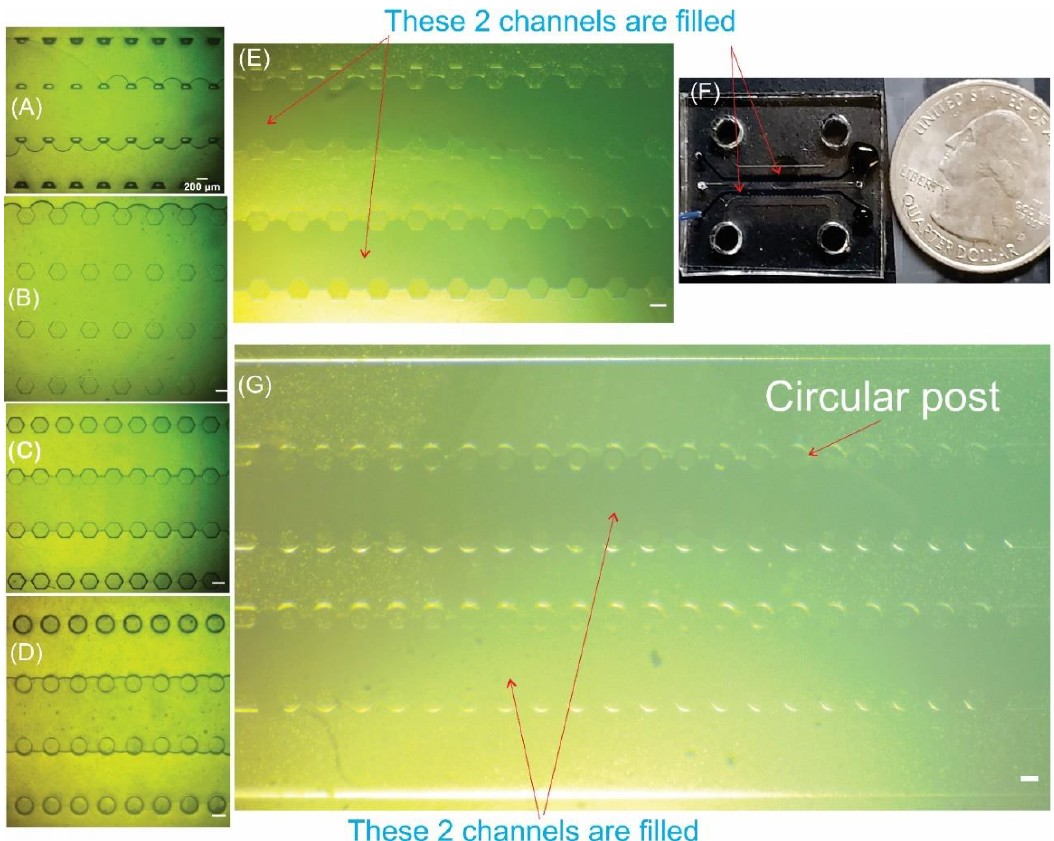
Figure 5. Microscope images of leakage from the middle channel to the neighboring compartments during liquid infusion using chips with 200 µm spacing distance for ( A ) trapezoidal posts and ( B ) hexagonal posts. Successful infusion of middle channels when using chips with 100 µm spacing distance for ( C ) hexagonal posts and ( D ) circular posts. Successful infusing multiple side channels for chips with 100 µm spacing distance for ( E , F ) hexagonal posts and ( G ) circular posts.